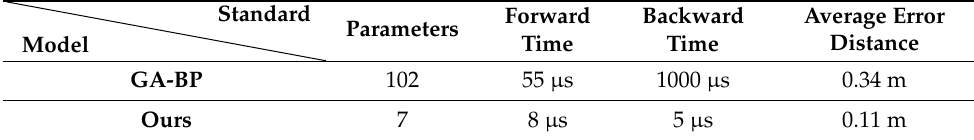
Table 4. Comparison result with GA-BP